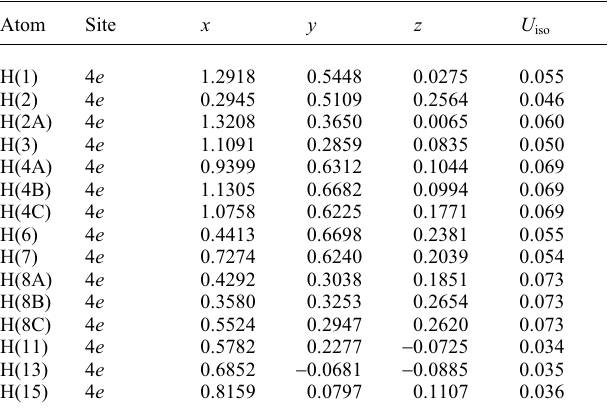
Table 2. Atomic coordinates and displacement parameters (in Å 2 )